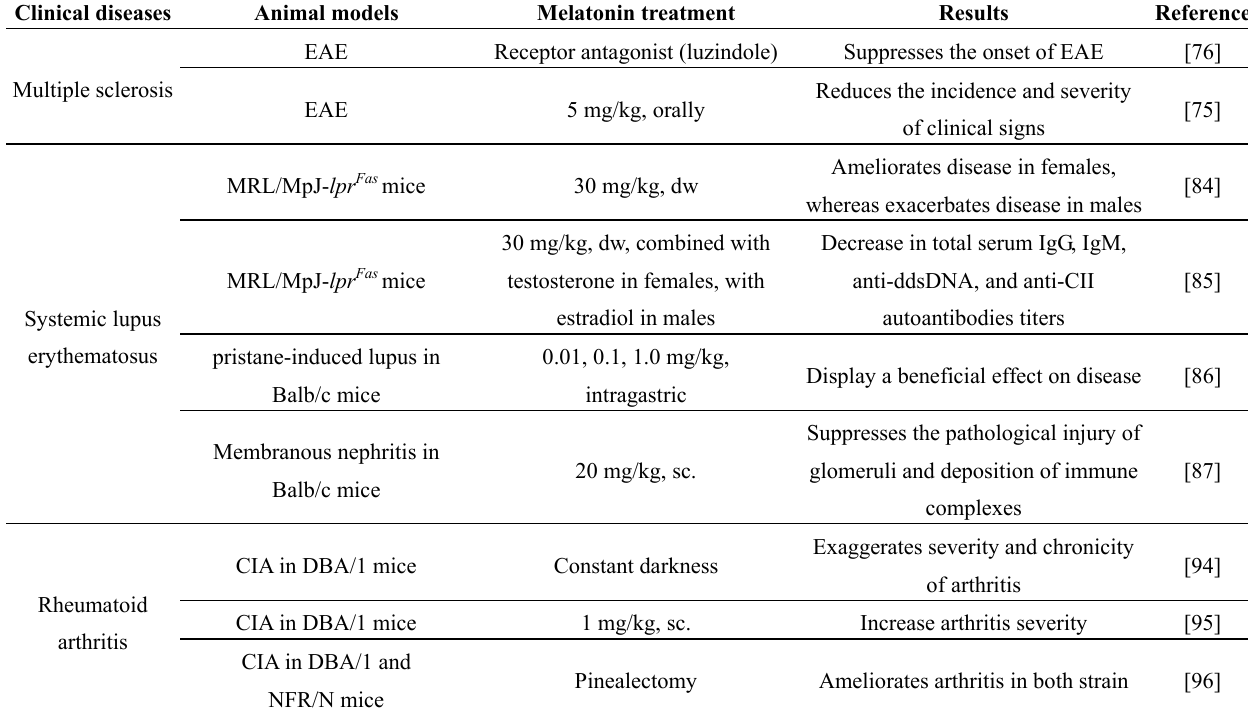
Table 1. The effects of melatonin in the animal model of autoimmune